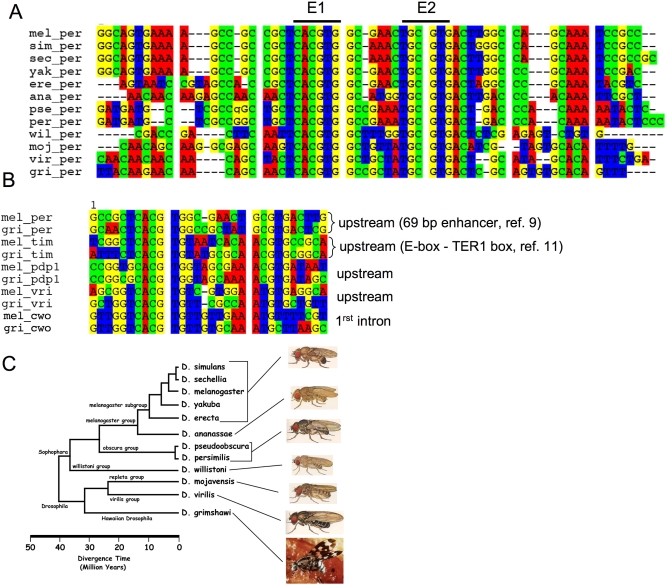
Period Enhancer and Related Sequences in Other CLK/CYC Targets(A) Alignment of the central part of the 69-bp enhancer in the Drosophila period gene in the 12 species. Locations of E1 and E2 boxes are indicated.(B) Similar sequences were found in promoters of the five known CLOCK/CYCLE targets: period, timeless, vri, Pdp1, and cwo (CG17100). Only the two most distant species are shown (D. melanogaster and D. grimshawi), but the elements are found across the full species tree.(C) Species tree of sequenced Drosophila (from http://rana.lbl.gov/drosophila).